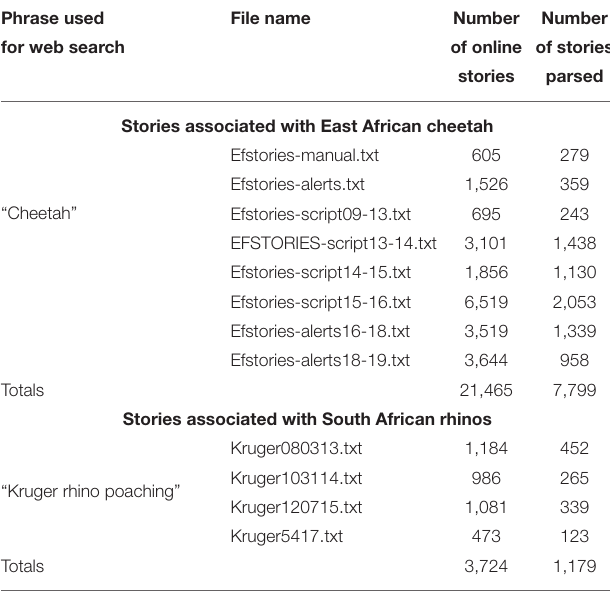
TABLE 2 | Raw HTML story files available on the East African cheetah ecosystem management tool website (Haas, 2019a), and South African rhino ecosystem management tool website (Haas,